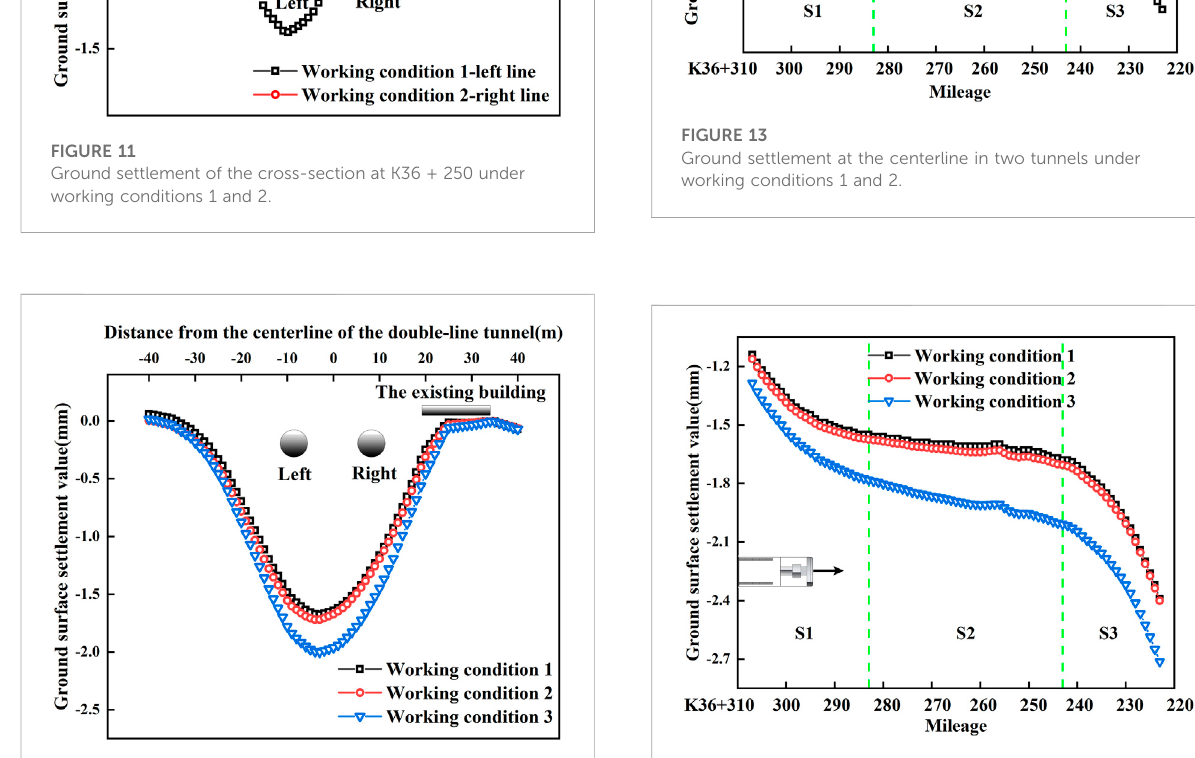
FIGURE 14 Ground settlement at the centerline in the two tunnels after the excavation in three working conditions. S1 ~ S3 are the three interval sections that underpass the existing